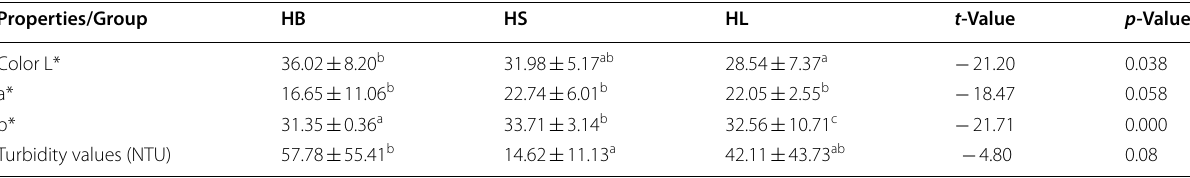
Values followed with the same letters (a, b and c) in column are not significantly different ( p >0.05) values with different letters are significantly different ( p < 0.05)